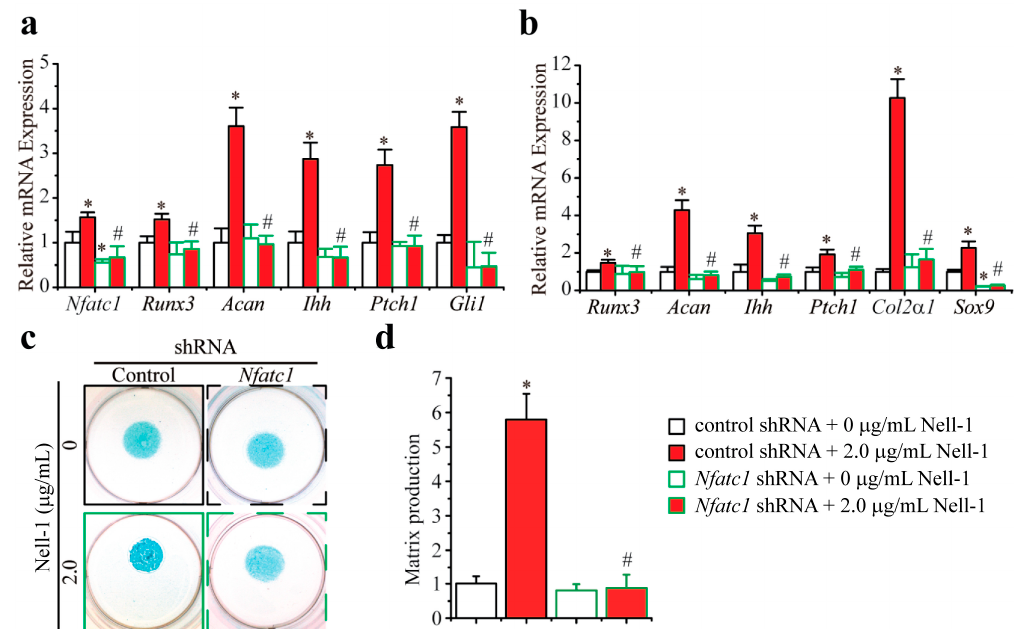
Figure 4. Nfatc1 is the bridging molecule between Nell-1 and the Runx3-Ihh signaling pathway in Runx2 − / − rib chondrocytes. ( a ) Transcription of Runx3 and Ihh signal-related molecules in monolayer cultured Runx2 − / − rib chondrocytes after 12-h stimulation of Nell-1; ( b ) Transcription of Runx3 and Ihh signal-related molecules in 3D micromass cultured Runx2 − / − chondrocytes after 3-day stimulation of Nell-1; ( c ) Alcian Blue staining of 3D micromass cultured Runx2 − / − chondrocytes after 3-day stimulation of Nell-1; ( d ) Alcian Blue incorporation into the extracellular matrix of micromass cultures reflecting the production of the proteoglycan-rich cartilaginous matrix at day 3 was quantified after extraction. The dye concentration of each group was normalized to that of the control shRNA + 0 µg/mL Nell-1 group. Mean + SD of three independent experiments performed in triplicate are shown. *: p < 0.05 vs. control shRNA + 0 µg/mL Nell-1, # : p < 0.05 vs. control shRNA + 2.0 µg/mL Nell-1.